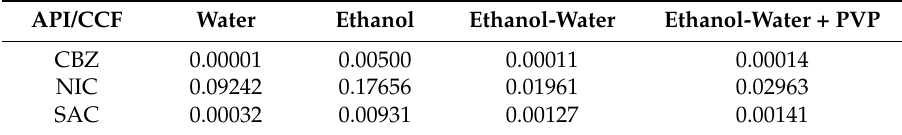
Table 1. Solubility of carbamazepine (CBZ), Nicotinamide (NIC), and saccharin (SAC) in different solvents (mol fraction); PVP (polyvinyl